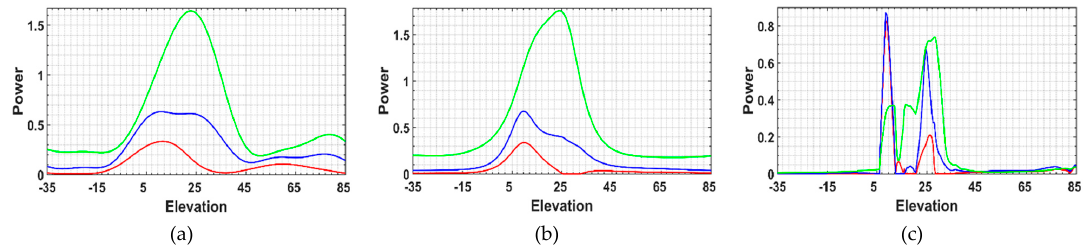
Figure 7. Extracted three-component features of forest pixel (shown in Figure 4 a ) from reconstructed T using ( a ) Beamforming, ( b ) Capon, ( c ) and the proposed method. Red, green and blue indicate the double-bounce, volumetric and surface scattering mechanisms.